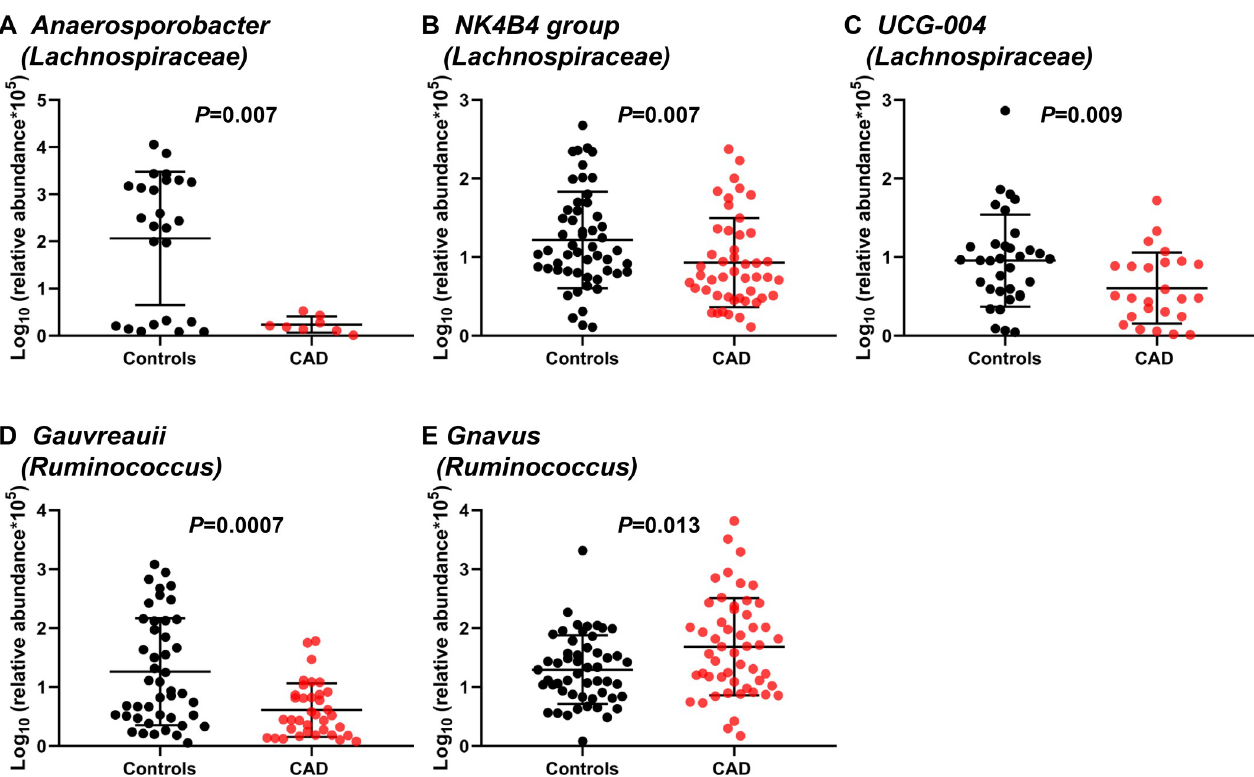
Fig 3. Comparison of relative abundance of gut microbes between patients with and without advanced CAD. (A) Lachnospiraceae Anaerosporobacter . (B) Lachnospiraceae NK4B4 . (C) Lachnospiraceae UCG-004 . (D) Ruminococcus Gauvreauii . (E) Ruminococcus Gnavus .